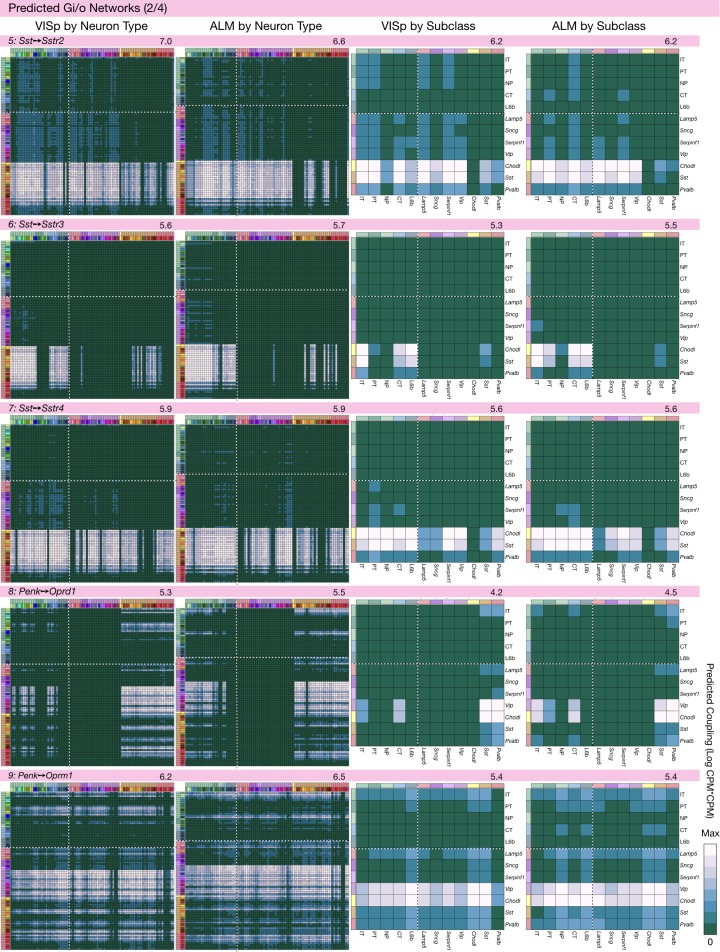
Neurotaxonomic coupling predictions for cognate NPP/NP-GPCR pairs #5-#9.Predictions for all 37 cognate pairs in both VISp and ALM cortical areas are grouped and color-coded according to Gα signal transduction family. All predictions were generated as described in connection with Figure 6 and represented as in Figure 6C–E for neuron types and in 6F for subclasses. Numbers at upper right indicate the maximum value to which each plot was normalized, in units of CPM*CPM.